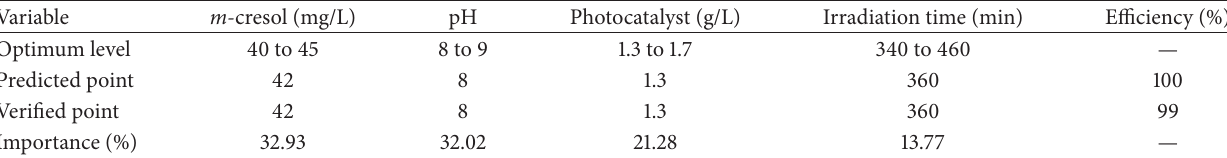
Table 2: The results of multivariate modeling and optimization of m -cresol photodegradation under visible-light irradiation.